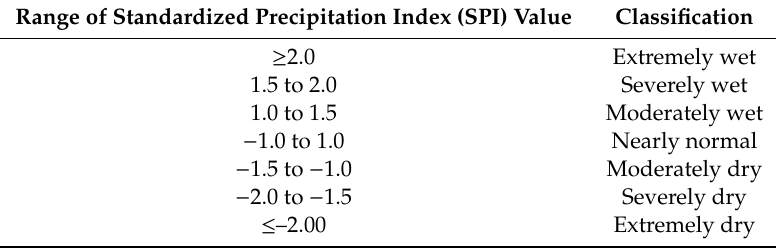
Table 1. Classification of wet / dry